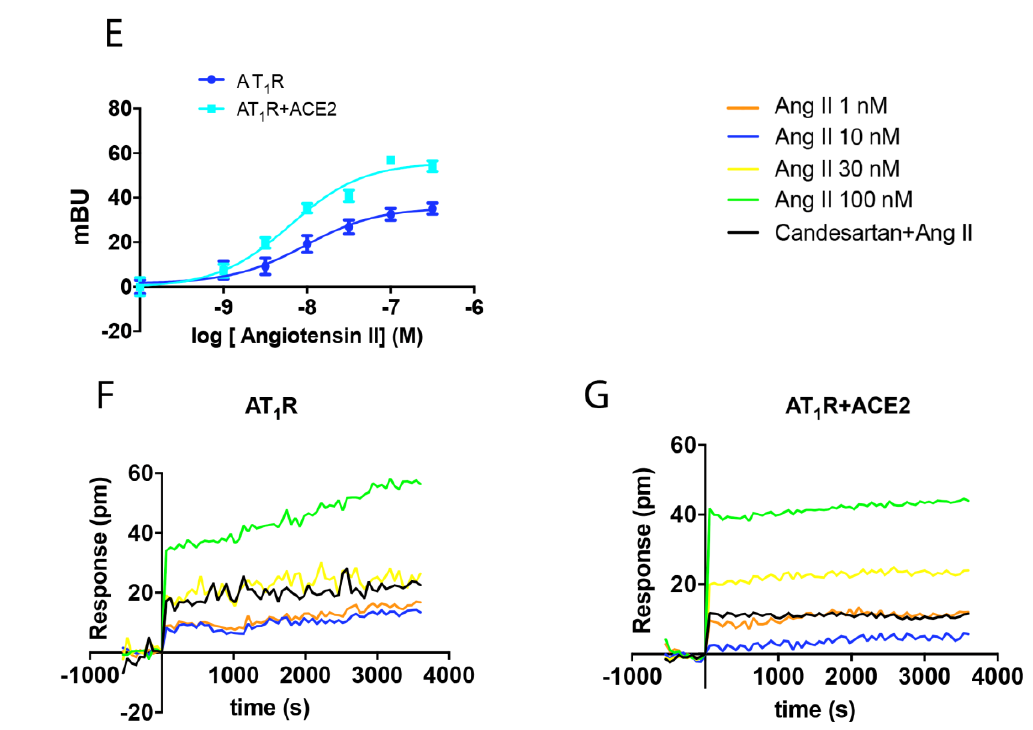
Figure 1. Impact of ACE2 on the functionality of AT 1 R. HEK-293T cells were transfected with either 0.4 µ g AT 1 R cDNA and 0.2 µ g ACE2-HA cDNA ( A , B , F , G ), 0.5 µ g AT 1 R-YFP cDNA, 0.2 µ g ACE2-HA cDNA, and 0.5 µ g β -arrestin II-RLuc cDNA ( C ), or 0.4 µ g AT 1 R cDNA, 0.2 µ g ACE2-HA cDNA, and 0.5 µ g cDNA encoding the Ca 2 + sensor, GCaMP6 ( D , E ). After 48 h of incubation, cells were treated with increasing concentrations of the AT 1 R agonist, Ang II. Cyclic AMP was measured after 15 min in response to pre-treatment with 0.5 µ M forskolin ( A ); as shown, this intervention resulted in approximately 4 nM cAMP, which corresponds to a 240% increase over baseline levels. Results from the evaluation of ERK1 / 2 phosphorylation ( B ), β -arrestin II recruitment ( C ) Ca 2 + levels ( D , E ), and DMR recordings ( F , G ) are presented as dose-response curves. Where indicated, cells were pre-treated with the selective AT 1 R receptor antagonist, candesartan (1 µ M), before challenge with the receptor agonist. Values shown are the mean ± SEM of 8 independent experiments each performed in